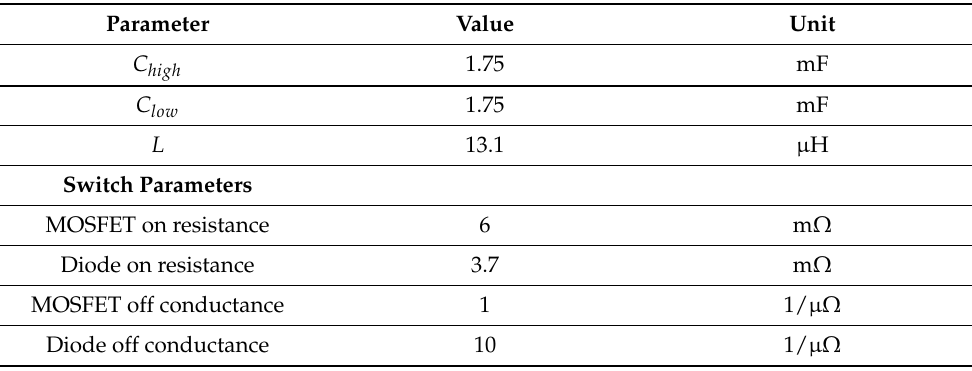
Table 2. Buck–boost converter parameters of proposed SMHB-based